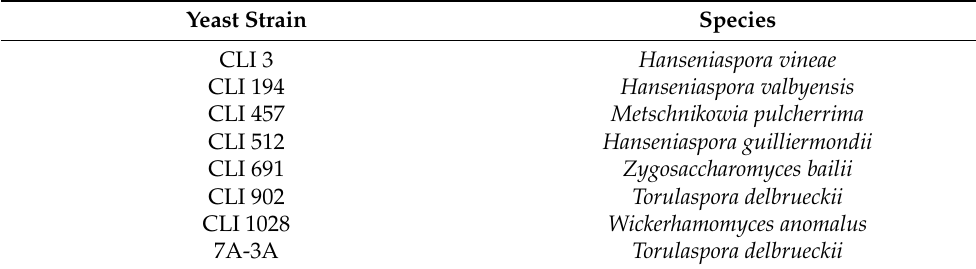
Table 1. Yeast strains used in single and sequential fermentation. Yeast